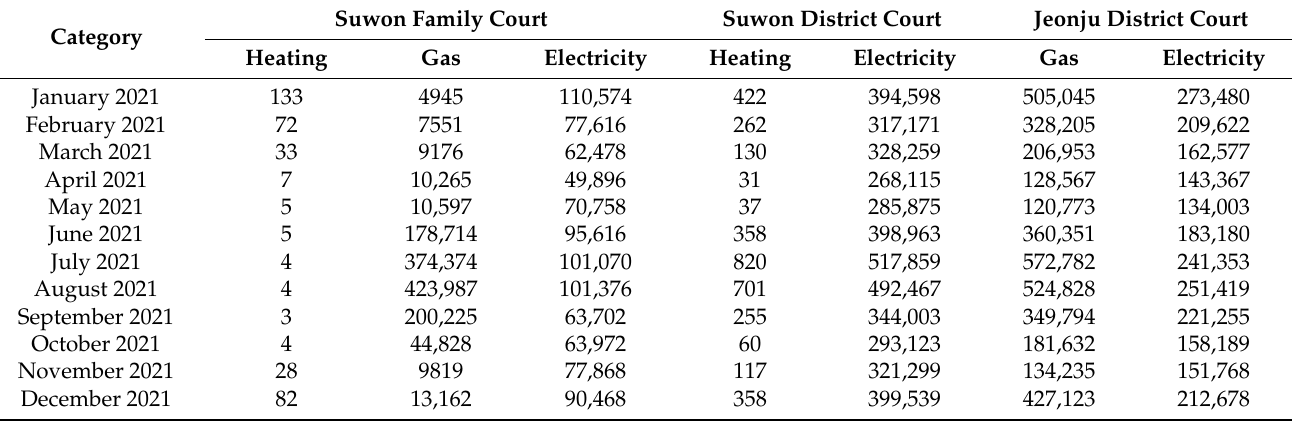
Table 4. Collected energy consumption data (G-SEED certified and after insulation thickness standard